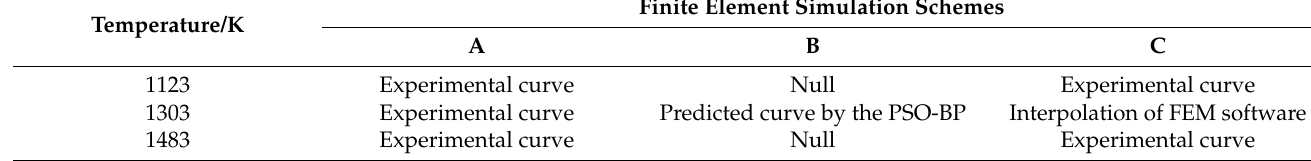
Table 8. The three finite element simulation schemes at the strain rate of 0.1 s − 1 and temperature of 1303 K.